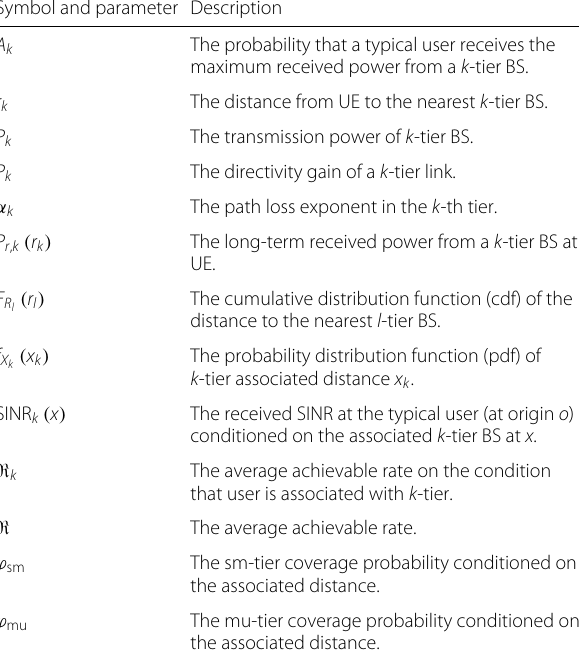
Table 1 Symbols and parameters for distributed user association Symbol and parameter